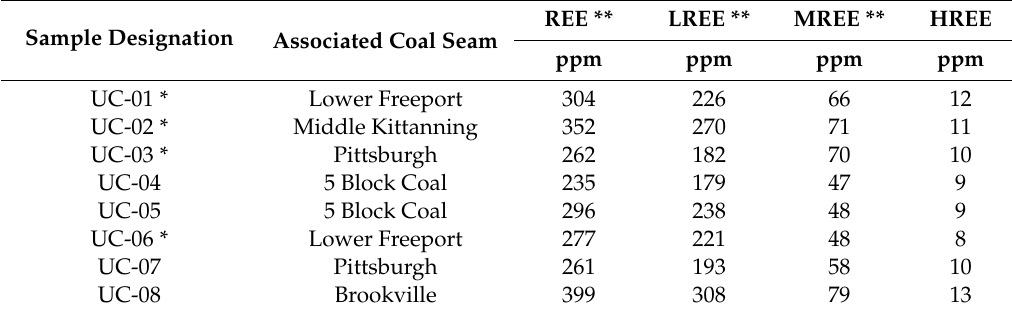
Table 3. Summary of REE content in Appalachian Basin